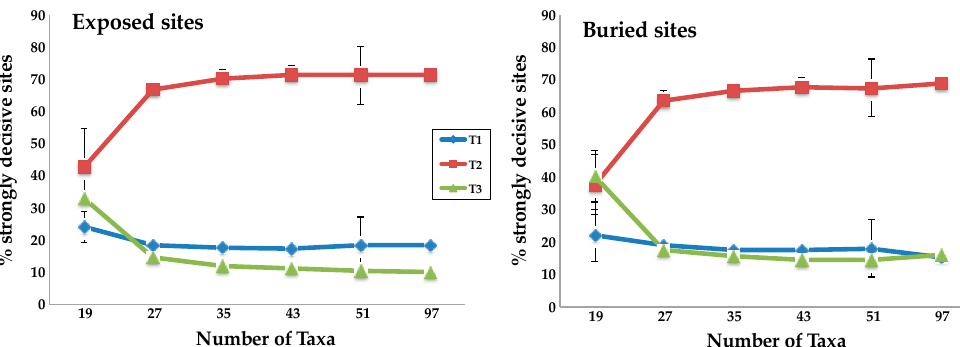
Figure 3. Taxon addition results in rapid convergence of the numbers of strongly decisive sites on the values found using the complete taxon set. The mean percentage of strongly decisive sites supporting each topology for the two subsets of site defined by relative solvent accessibility (RSA.) Error bars indicate the standard deviation for the 40 taxon sampling replicates. We observed similar results for the subsets defined using secondary structure (SS) (Supplementary Figure S2).